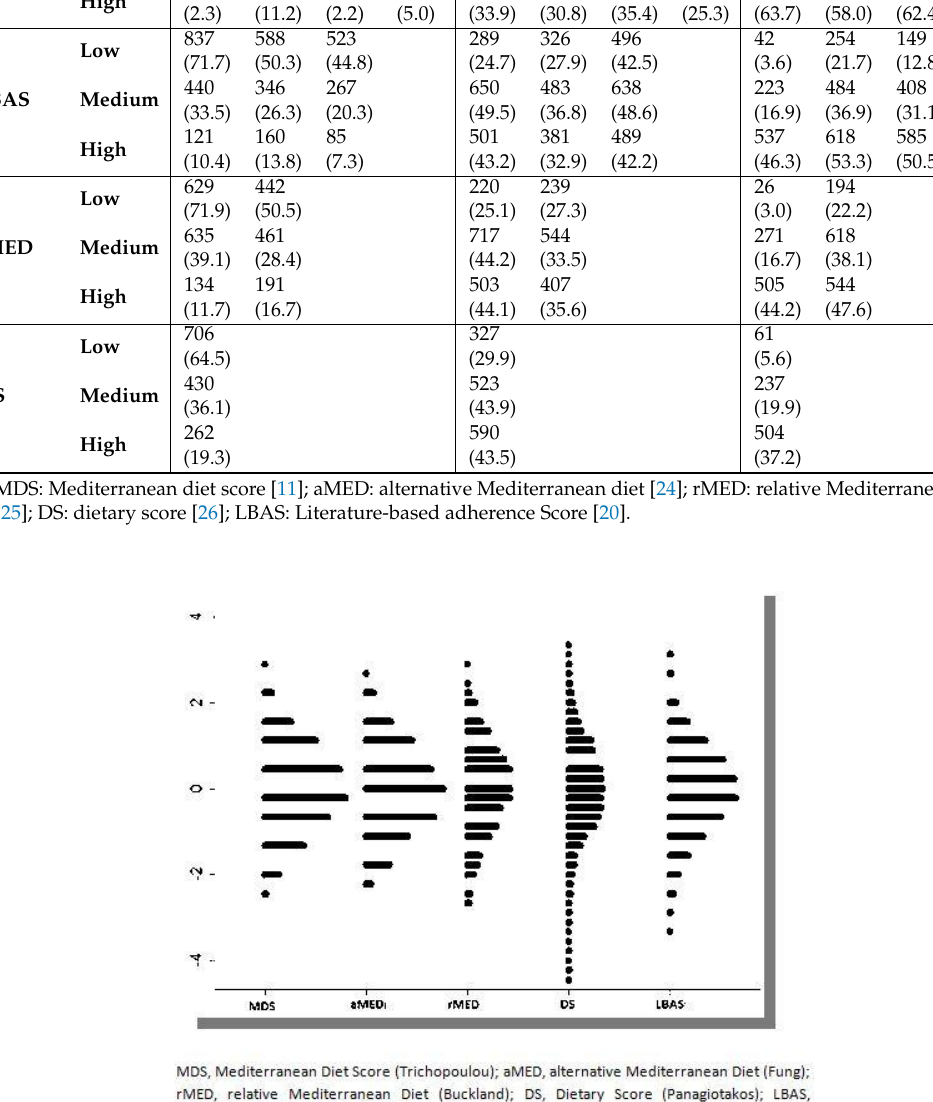
Figure 2. Dotplot representing standardised values of score according to each Mediterranean diet index ( n = 3640). Table 4. Reliability among the indexes of adherence to the Mediterranean diet pattern (three categories: low, medium and high adherence).